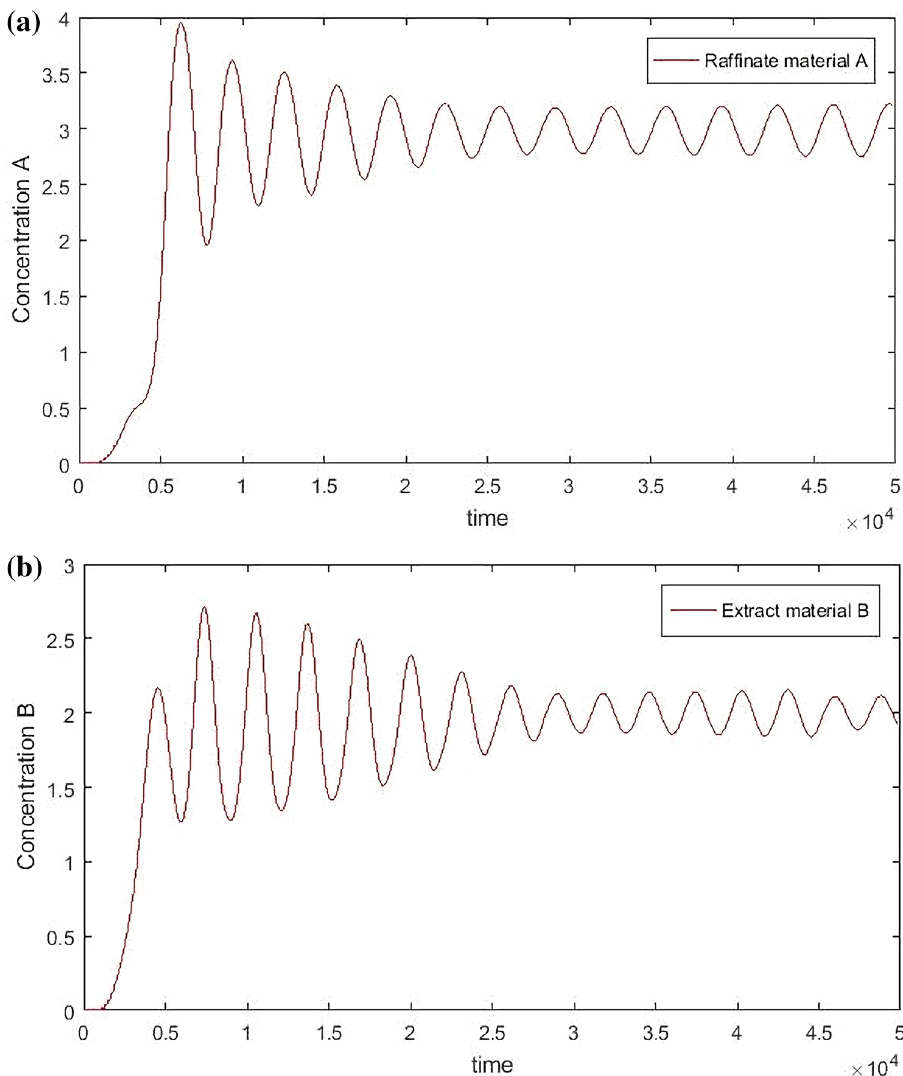
Figure 12. Hierarchical Fuzzy Rule Control for concentration, desired B = 2, desired A = 3 Switch time = 180